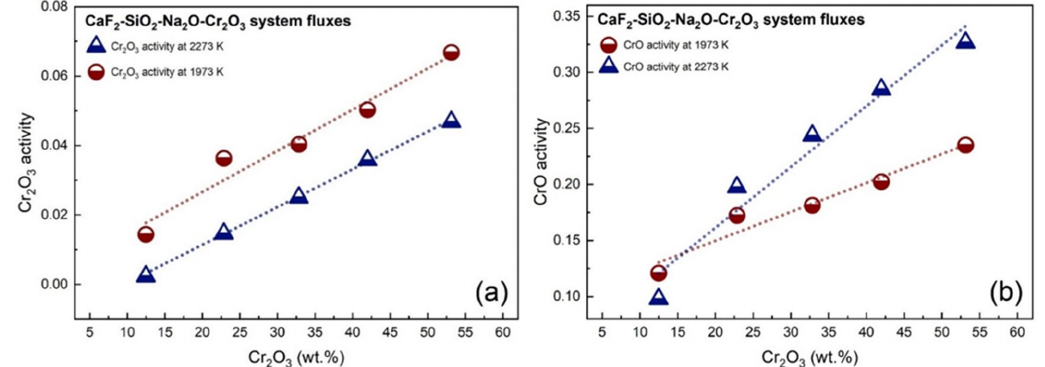
Figure 5. Gas ‐ slag ‐ metal equilibrium activities of Cr oxides: ( a ) Activity of Cr 2 O 3 , ( b ) Activity of